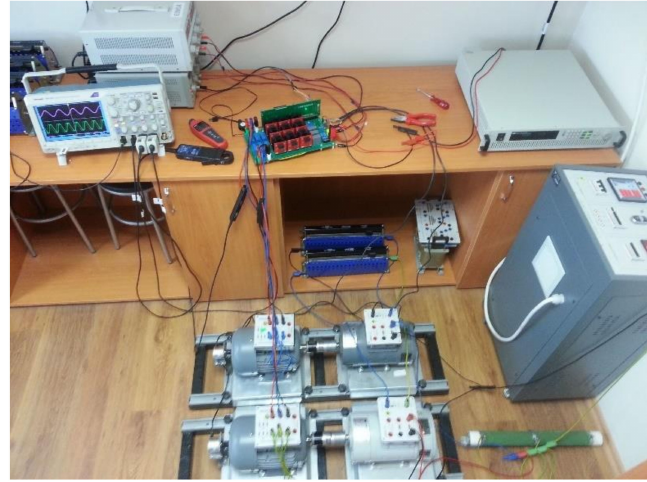
Figure 6. Overview of the experimental test